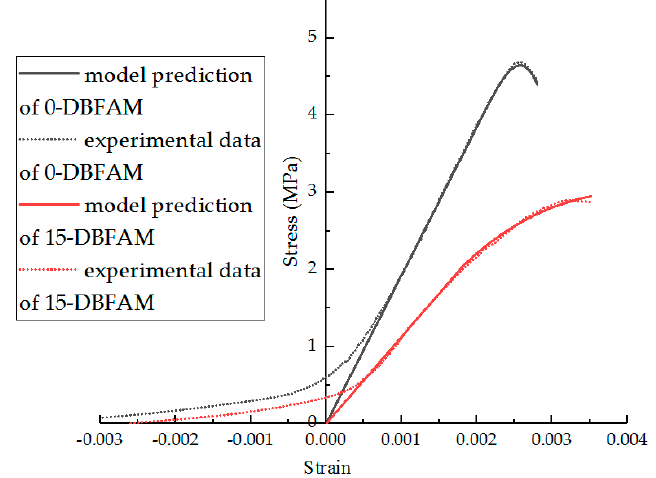
Figure 23. Comparison of experimental data and model predictions for DBFAM under F–T cycles.